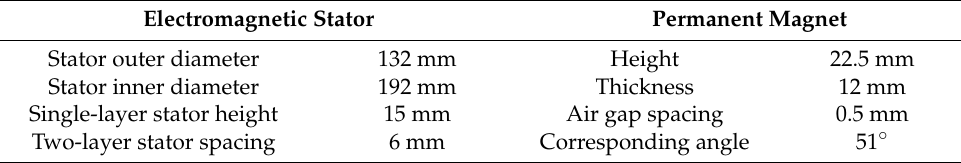
Table 1. Electromagnetic structure